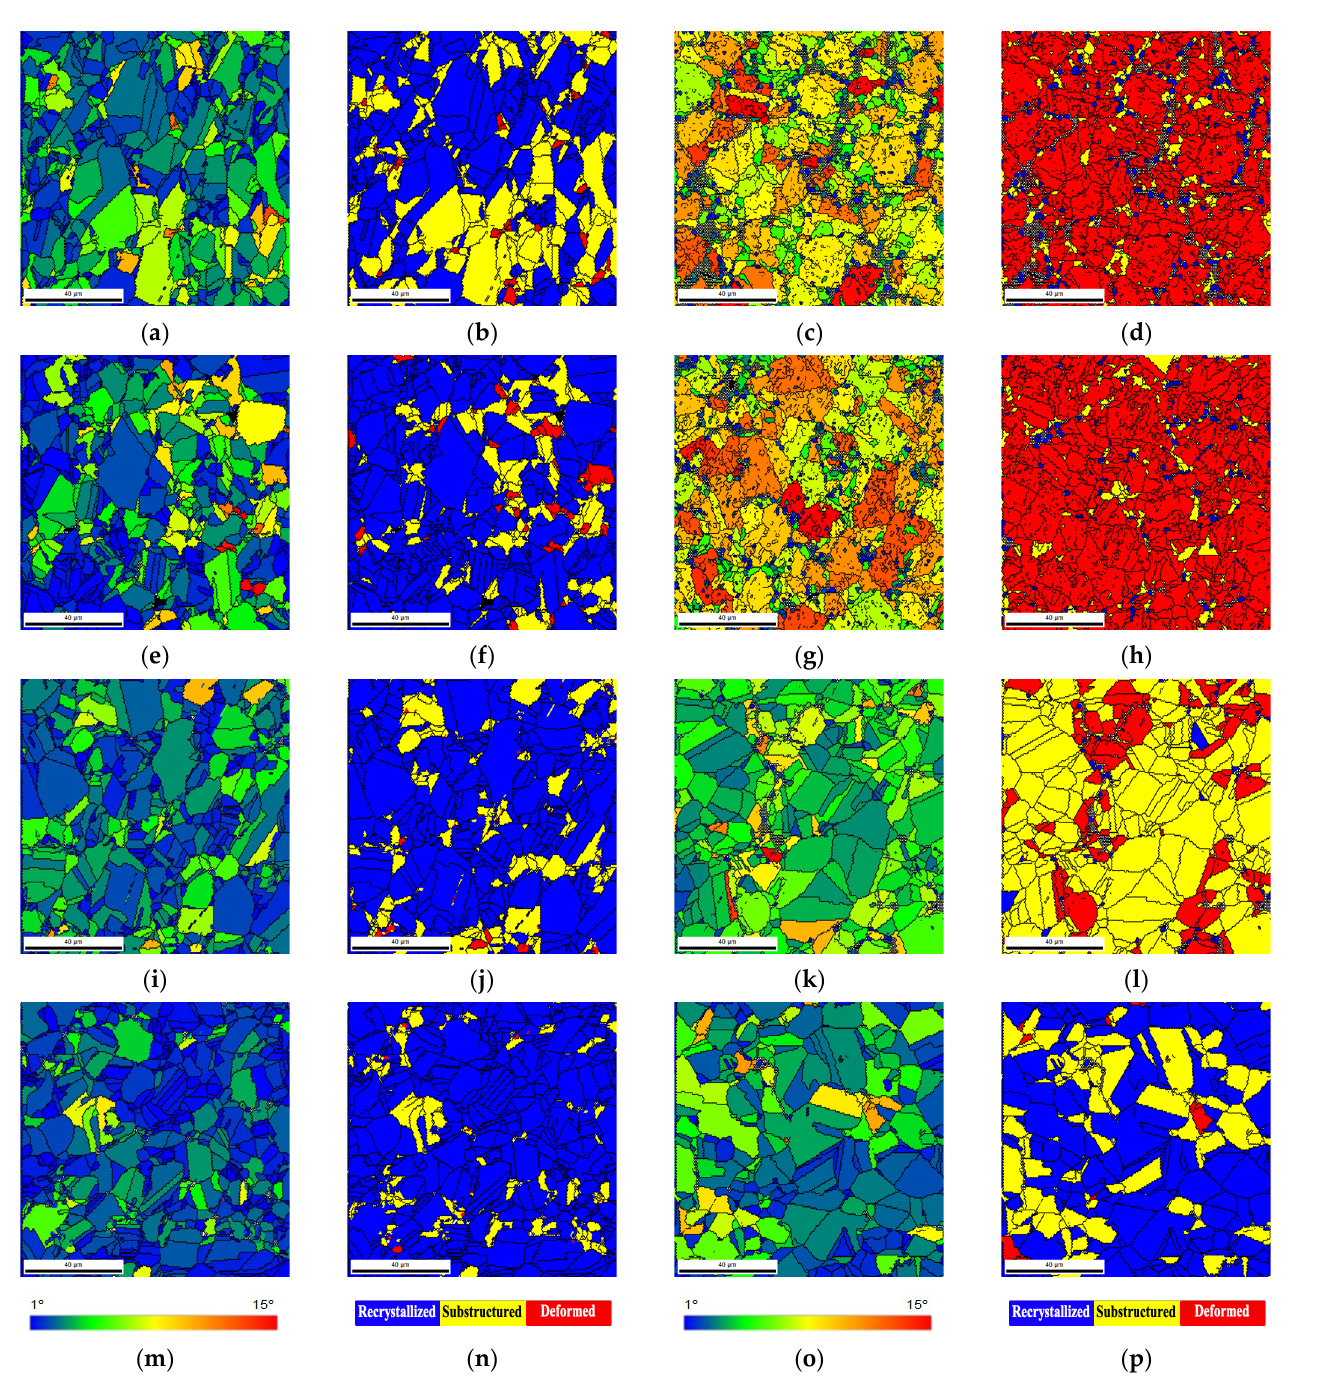
Figure 9. GOS and recrystallization maps of ( a , b ) Ni as-sintered, ( c , d ) Ni-1.00 vol.% CNT as-sintered, ( e , f ) Ni heat-treated at 700 ◦ C for 120 min, ( g , h ) Ni-1.00 vol.% CNT heat-treated at 700 ◦ C for 120 min, ( i , j ) Ni heat-treated at 1100 ◦ C for 30 min, ( k , l ) Ni-1.00 vol.% CNT heat-treated at 1100 ◦ C for 30 min, ( m , n ) Ni heat-treated at 1100 ◦ C for 120 min, ( o , p ) Ni-1.00 vol.% CNT heat-treated at 1100 ◦ C for 120